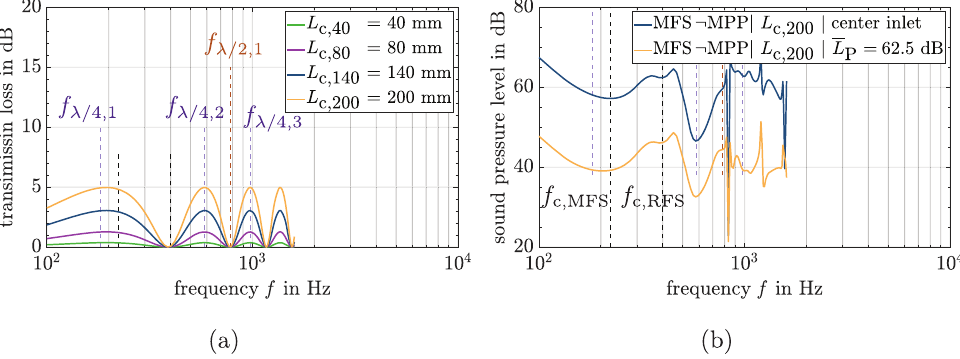
(cid:3) L P compared to single center inlet